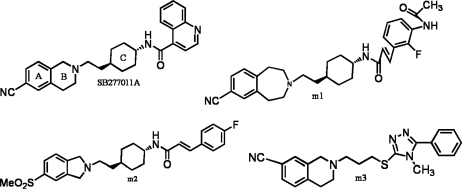
The structures of SB277011A, m1, m2 and m3 [1].